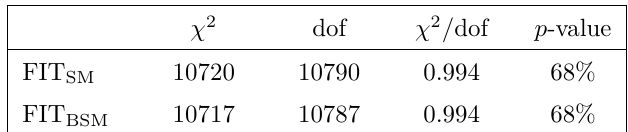
(FIT ) and the full one SM 0